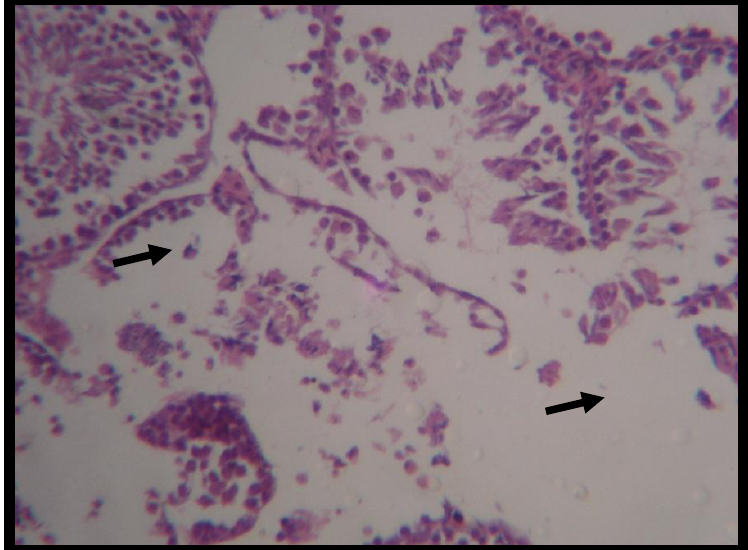
Fig. 5: Histopathological section of testis of the male Mice after 30 days post treatment with smut wheat show desquamation of sertoli cells and spermatogonium from the basement membrane of semineferous tubules as well as fibrous interstitial tissue ( ) & in some region completely degeneration were observed , (H & E